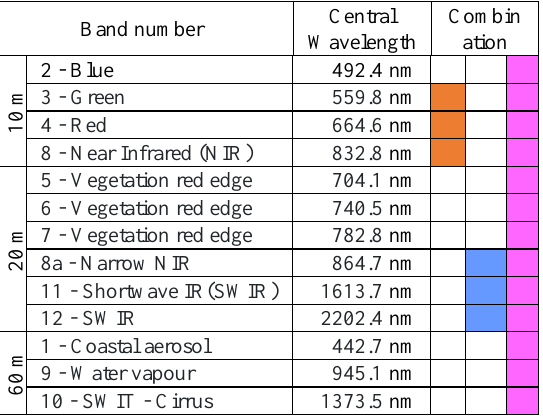
Table 2: Spectral bands of Sentinel-2 given by the European Space Agency